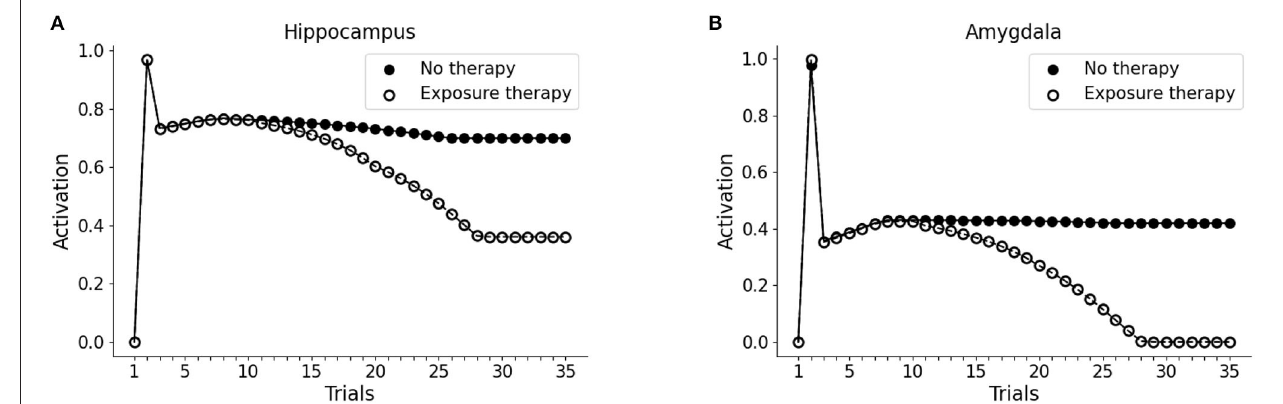
FIGURE 6 | Effect of PE on hippocampus (A) and amygdala (B) . The first 10 trials were as in Figure 1 : trial 1 was the baseline V1 activation of hippocampus and amygdala; trial 2 marked the trauma experience (A1-S1-V1-Trauma); trials 3–10 involved the re-experience of V1 to observe the effect of the trauma. After trial 10, however, we administered PE for 20 sessions (20 trials in the model). PE consisted in the activation of the hippocampal memory trace (unit H3 from the Figures 3A and B ), coupled with the activation of vmPFC. Each time point in trials 11–30 corresponds to a V1-activation test after a PE session (trial). After the 20 trials of therapy, hippocampal activation is reduced to a plateau (A) and amygdala activation becomes zero (B) : the memory has been freed from the negative emotional